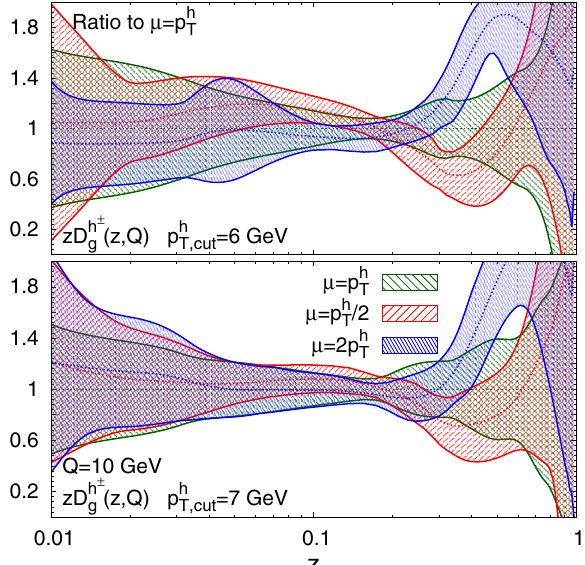
Fig. 6 Comparison of the gluon FF at Q = 10 GeV for the fits performed setting the scale μ in Eq. (2) to p h = 6 GeV (upper) and the baseline p h p h T , cut normalised to the μ = p h